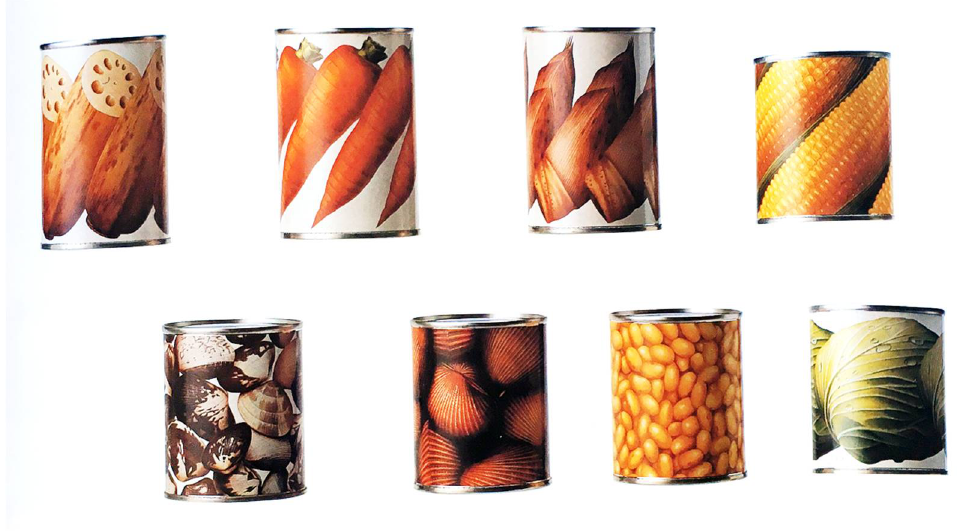
Figure 2. Shin Matsunaga, packaging for Kibun,